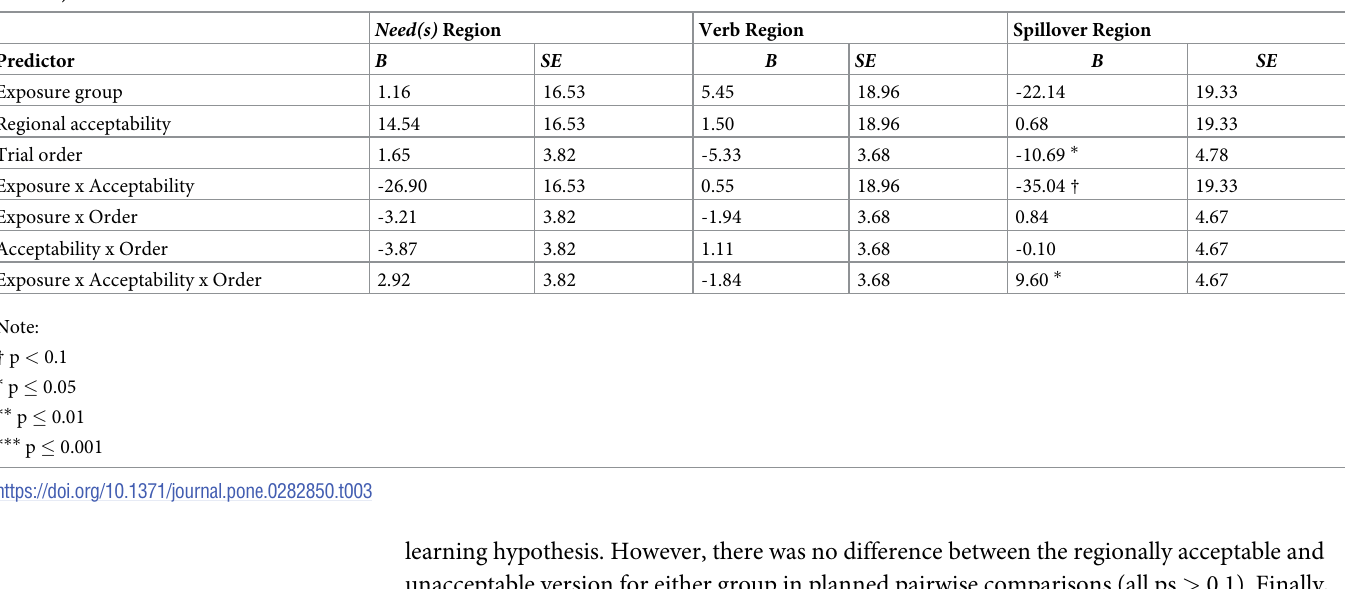
Table 3. Experiment 1 test block fixed effects summary for the three regions of analysis: The need(s) region, the critical verb region, and the spillover region (i.e., verb + 1).